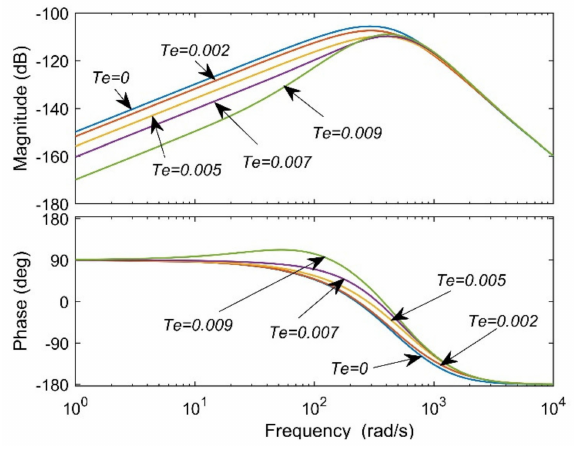
Figure 11. Frequency domain characteristics of the disturbance term of the improved